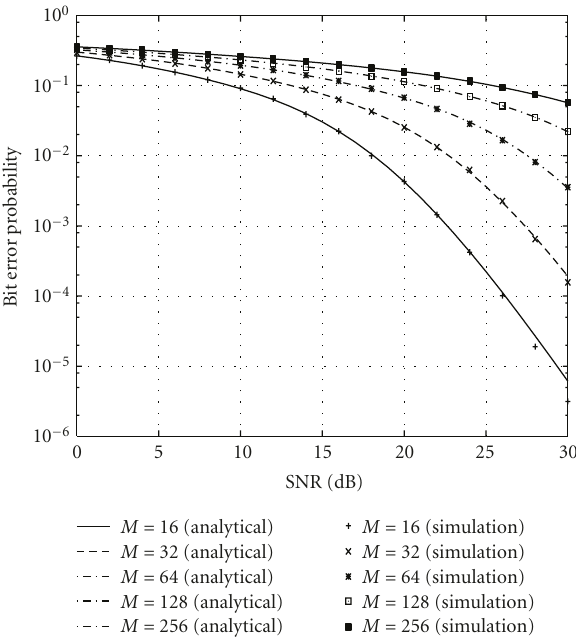
Figure 5: BEP for 64-PAM subject to Nakagami- m fading for di ff erent values of m .